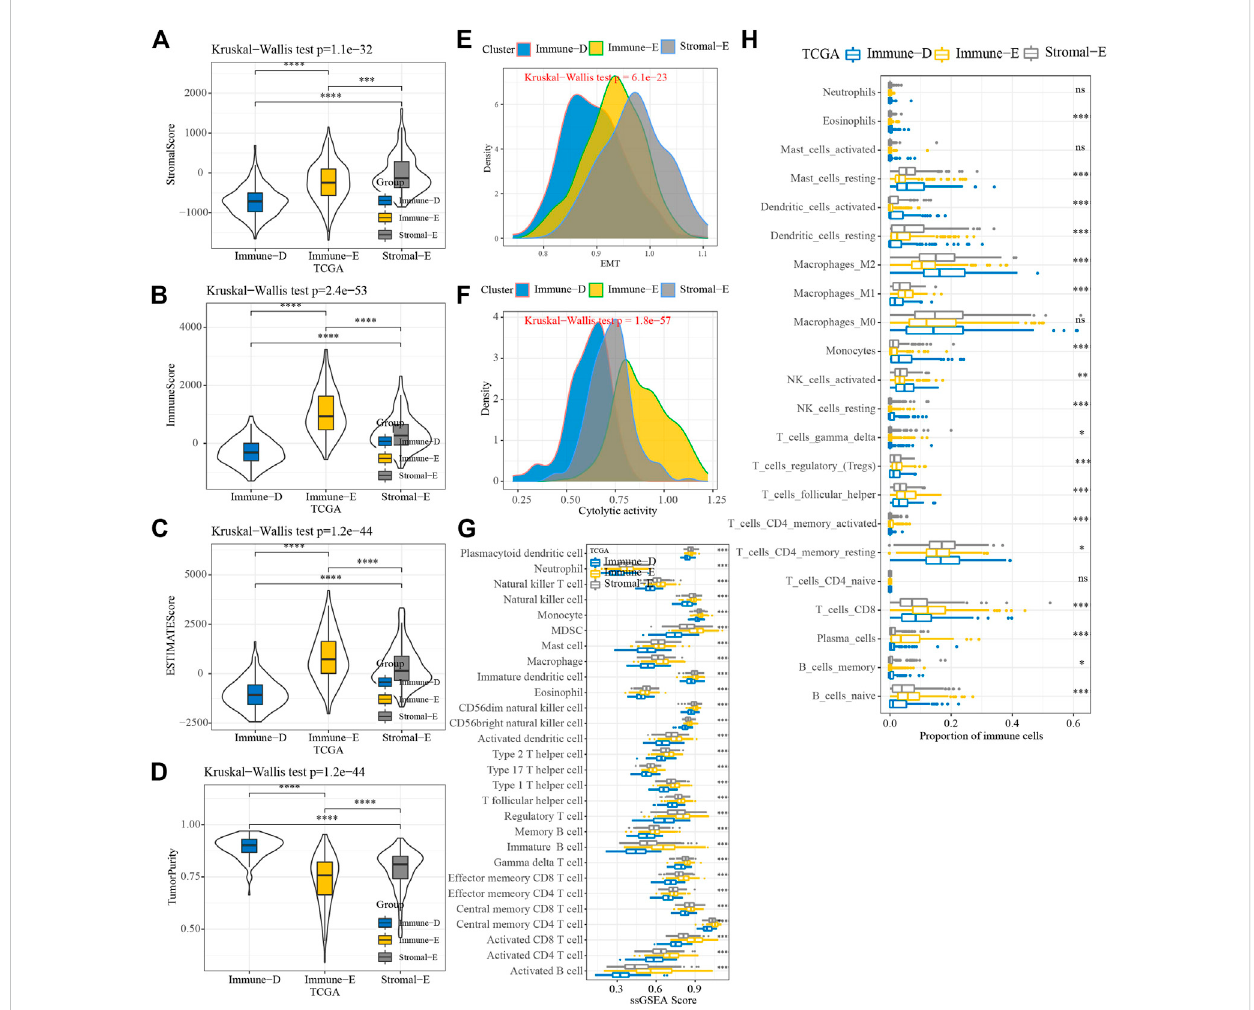
FIGURE 2 Immune in fi ltration analysis among three molecular subtypes. (A) Distributions of StromalScore among the three molecular subtypes. (B) Distributions of ImmuneScore among the three molecular subtypes. (C) Distributions of ESTIMATEscores among the three molecular subtypes. (D) Distributions of TumorPurity among the three molecular subtypes. (E) Differences in EMTscores among the three molecular subtypes. (F) Differences in cytolytic activity among the three molecular subtypes. (G) Differences in the scores for 28 kinds of immune cells among the three molecular subtypes. (H) Differences in the scores for 22 kinds of immune cells among the three molecular subtypes. * p < 0.05; ** p < 0.01; *** p < 0.001; **** p < 0.0001; ns: no signi fi